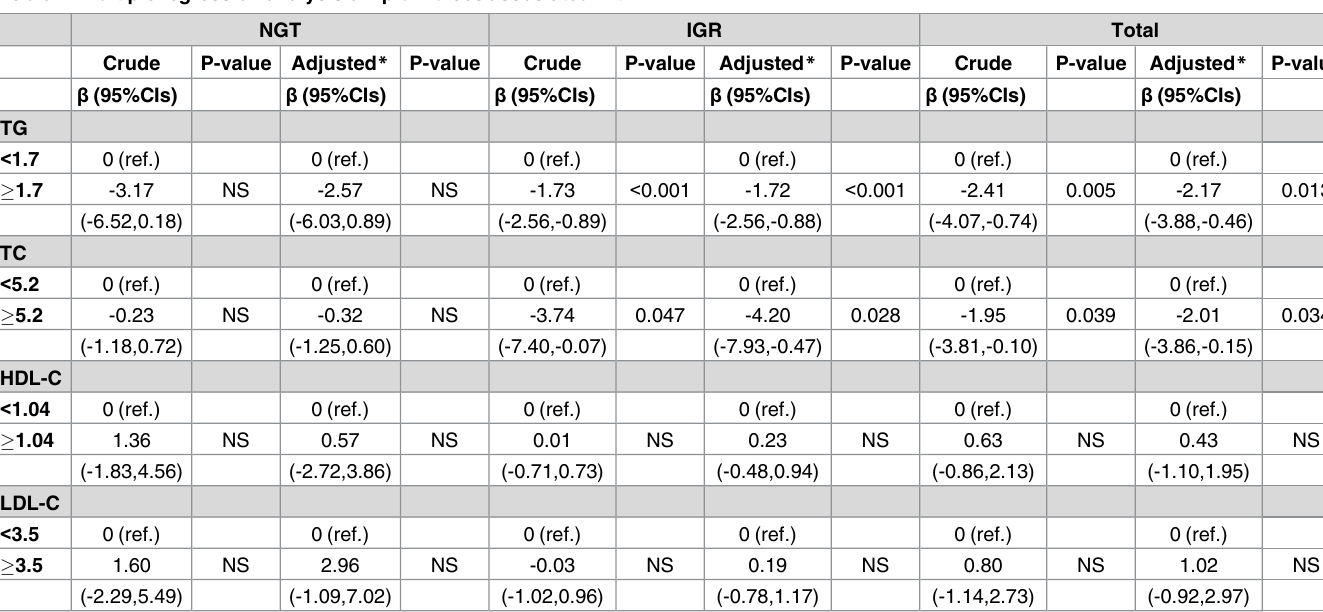
Table 4. Multiple regression analysis of lipid indices associated with